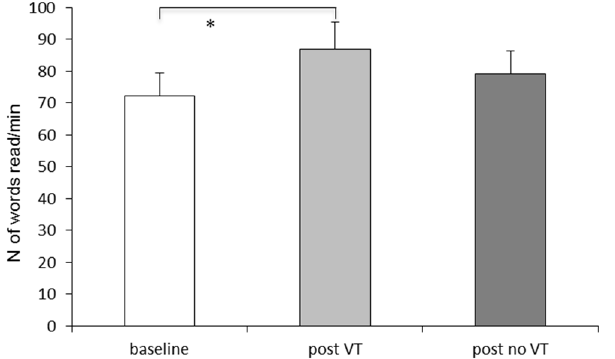
Figure 6. Mean and standard error of the number of words read in 1 min in the three different periods (baseline, post VT and post no VT). Asterisk indicates significant difference between the two conditions.